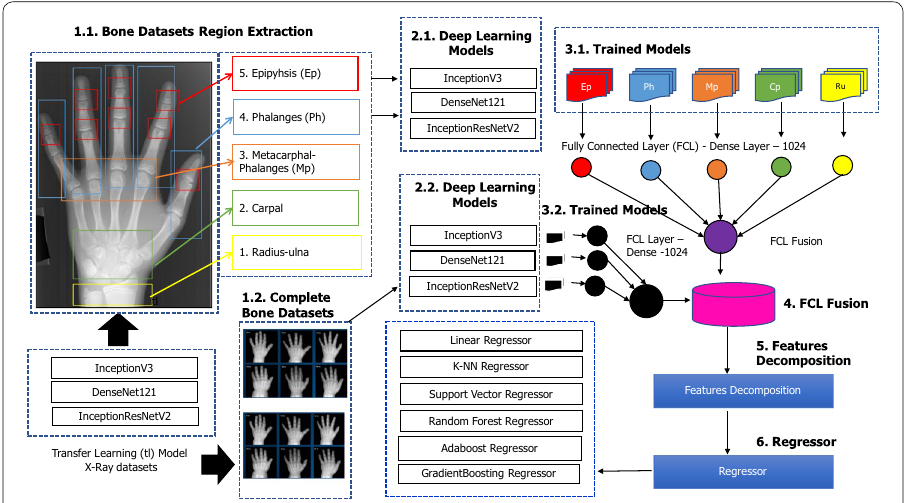
Fig. 2 Region-Based Feature Connected Layer (RB-FCL)